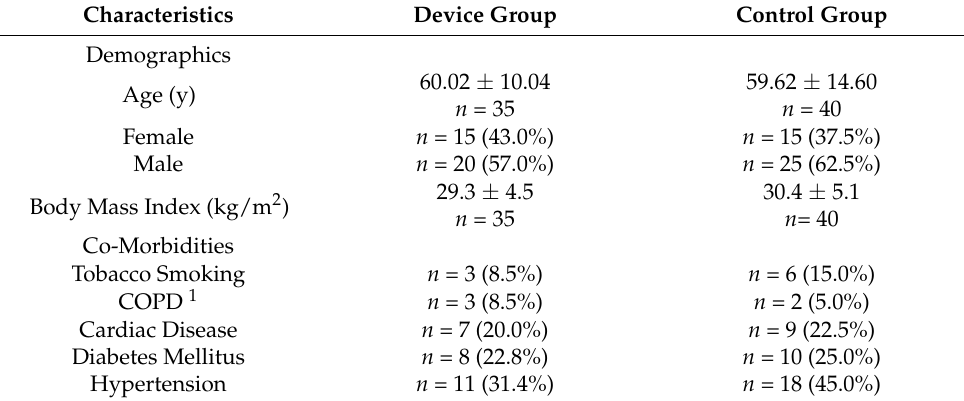
Table 4. Baseline Patient Characteristics.